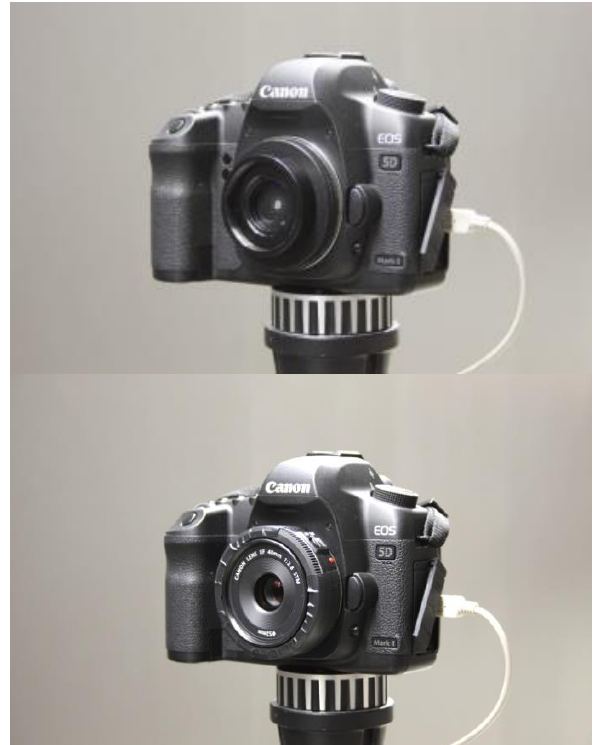
Figure 2. Pinhole optical system (top) and glass optical system